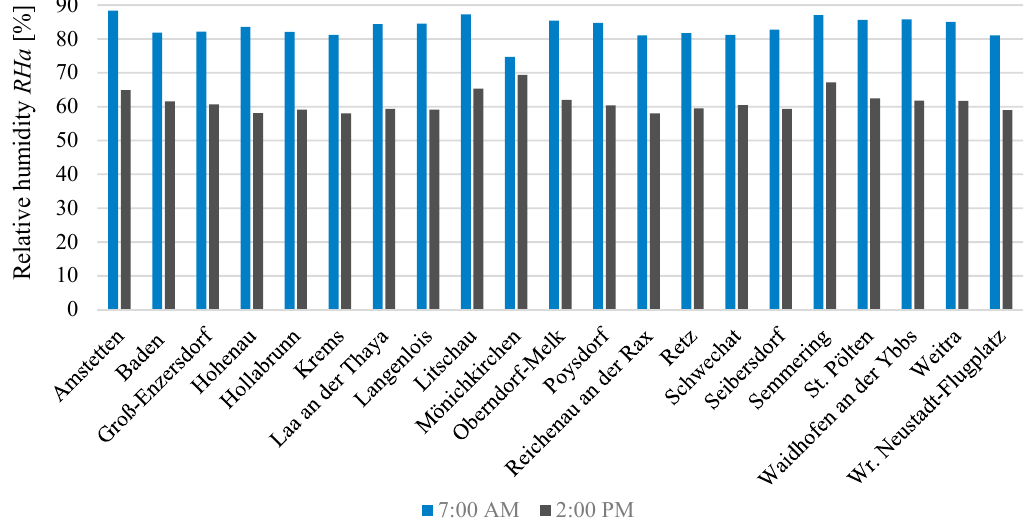
Figure 7. Average relative humidity RH a for weather stations in the state of Lower Austria in the period 1981–2010, measured at 7:00 a.m. and 2:00 p.m. [58].